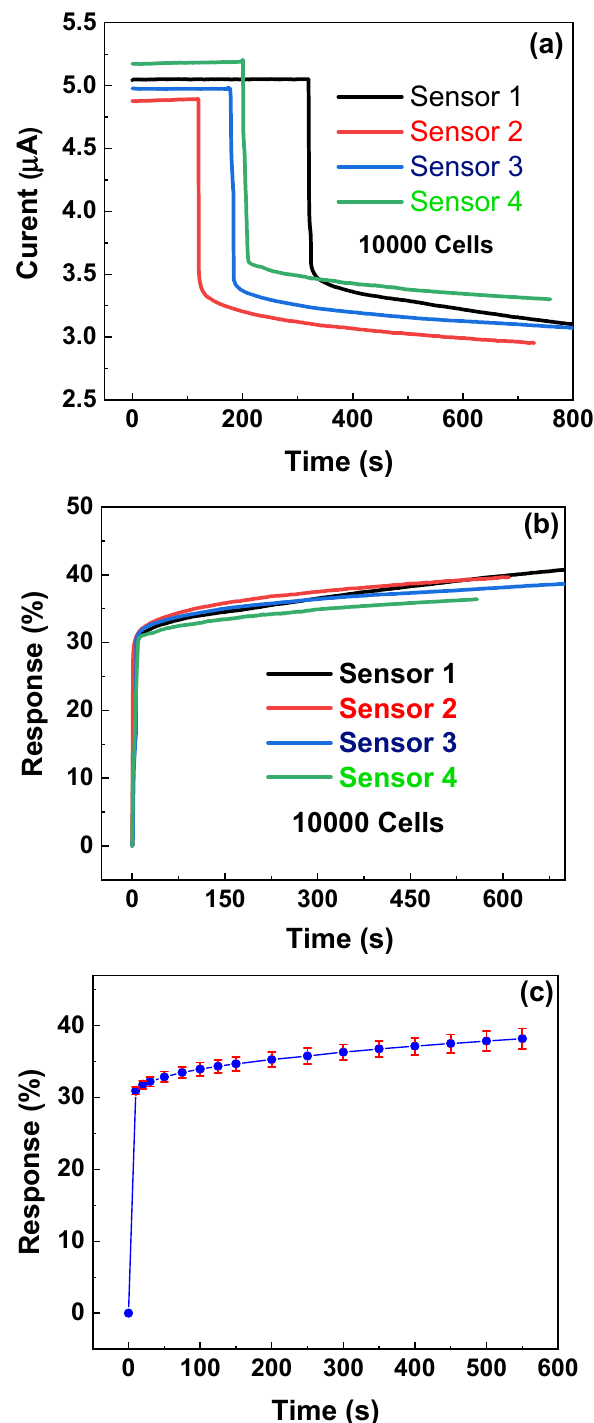
Figure 6. Time dependence of currents ( a ) and response ( b ) of four different sensors. ( c ) Time dependency of response with error bars; data calculated from ( b ).